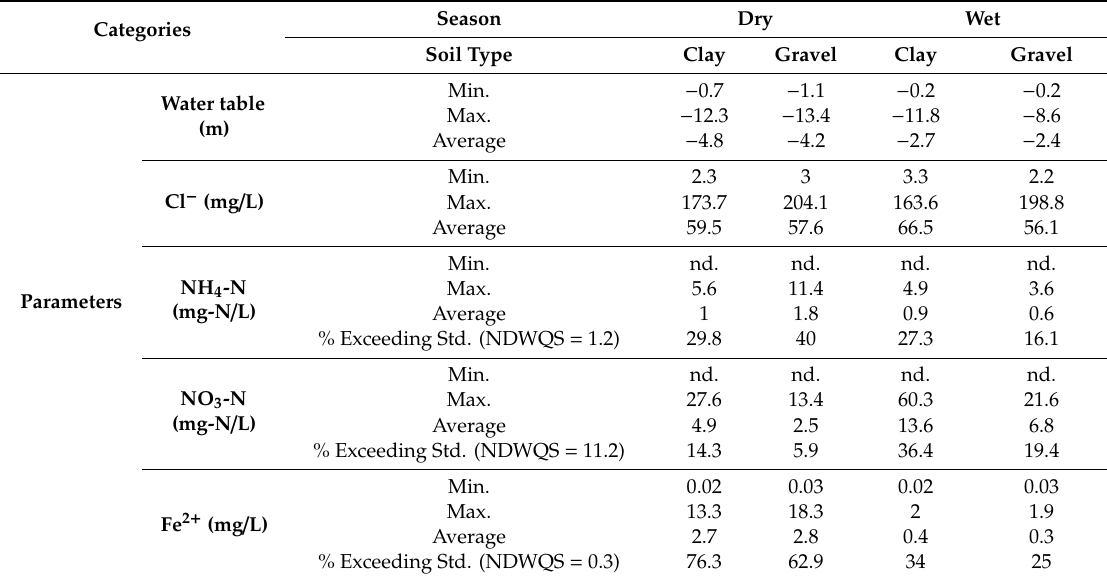
Table 1. Descriptive statistics of water table level and chemical concentrations collected from shallow dug